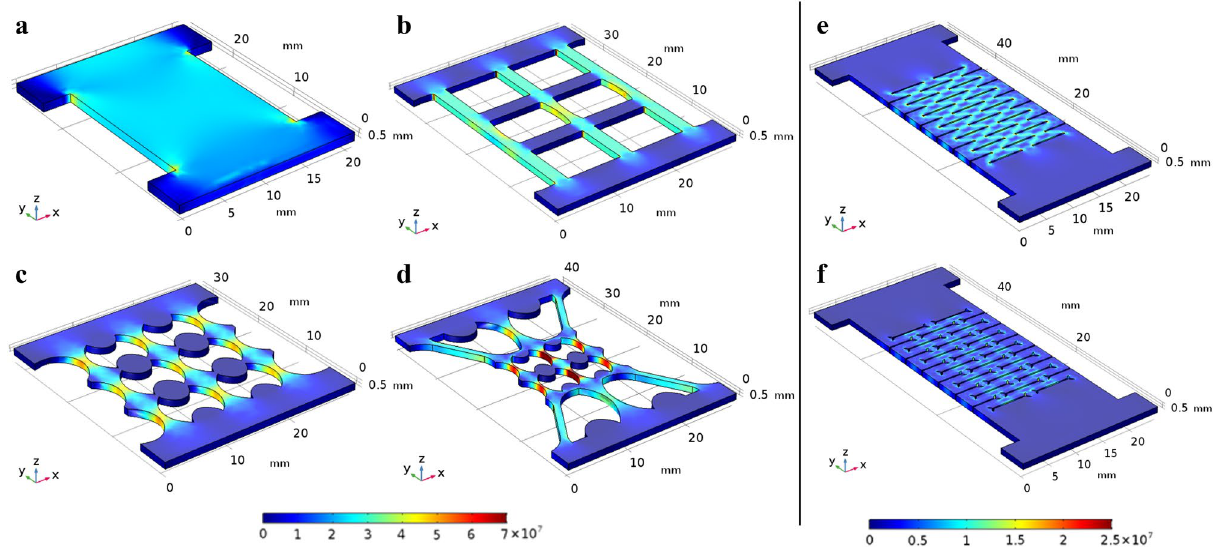
Figure 2. FE analysis of the mechanical response of the different topological designs. Von Mises stress field distributions in the ( a ) Non-patterned, ( b ) Grid, ( c ) Dog-Bone Grid, ( d ) Hierarchical Dog-Bone, ( e ) Kirigami structure, and ( f ) the Modified Kirigami